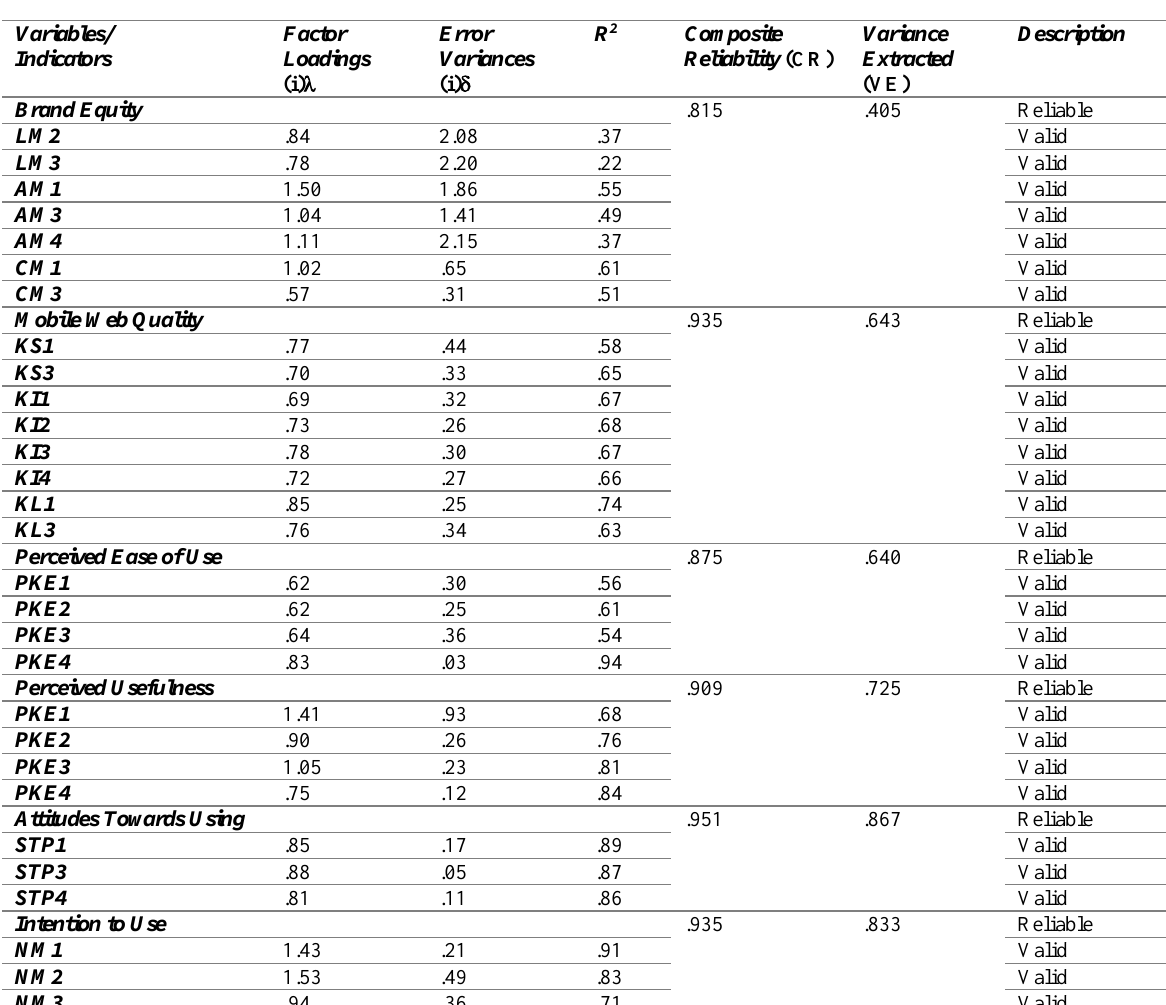
Table 2: Results of Research Validity and Reliability